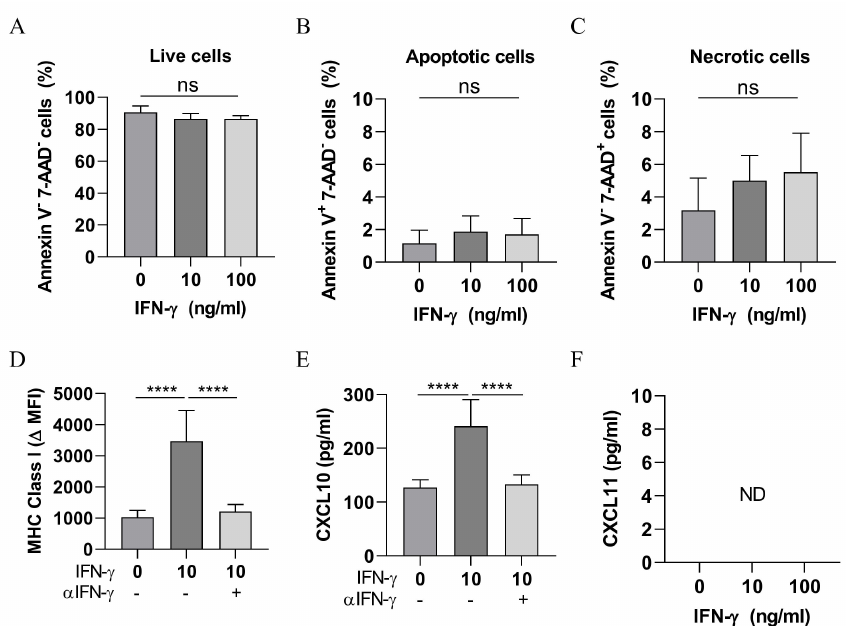
Figure 4. Direct effects of IFN- γ on SCC. ( A – C ) Viability of SCC cells following IFN- γ treatment. SCC cells were treated with IFN- γ for 72 h and then assessed for Annexin V and 7AAD staining by flow cytometry. Bars represent mean ± SD, n = 6/group, one-way ANOVA. ( D ) MHC class I expression. The delta mean-fluorescence-intensity ( ∆ MFI) of H-2K q is shown. Bars represent mean ± SD, n = 6–9/group, one-way ANOVA followed by Tukey’s multiple comparisons test. p < 0.0001 (****), ( E ) CXCL10 and ( F ) CXCL11 secretion in supernatants assessed by ELISA assay. Bars represent the mean ± SD, n = 6–9/group, one-way ANOVA followed by Tukey’s multiple comparisons test ( E ). Data are derived from 3 independent experiments with similar results. p < 0.0001 (****), ND = not detected. ns = not